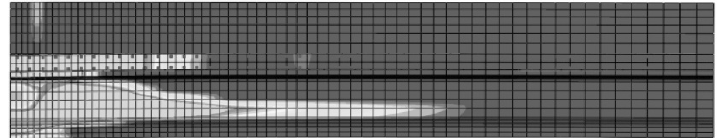
Fig. 25. Maximum principal plastic strain, blast above, centered on a girder. Side view of internal girder.